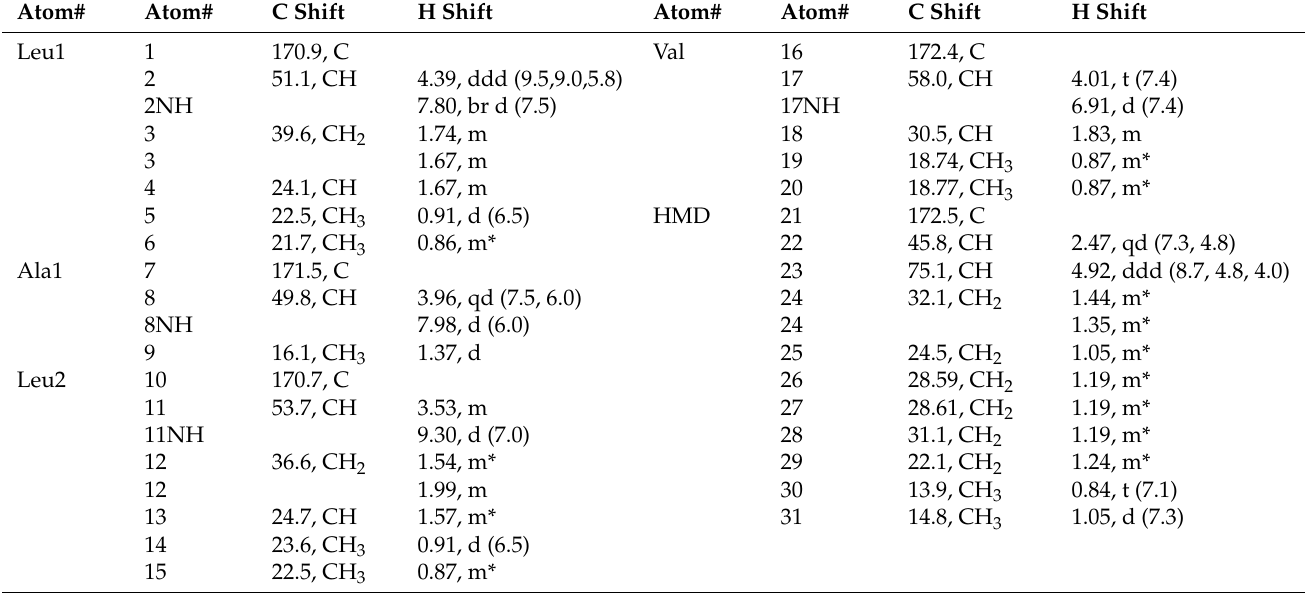
Table 2. NMR data ( 1 H 700 MHz, 13 C 175 MHz) of morinagadepsin 1 in DMSO- d 6